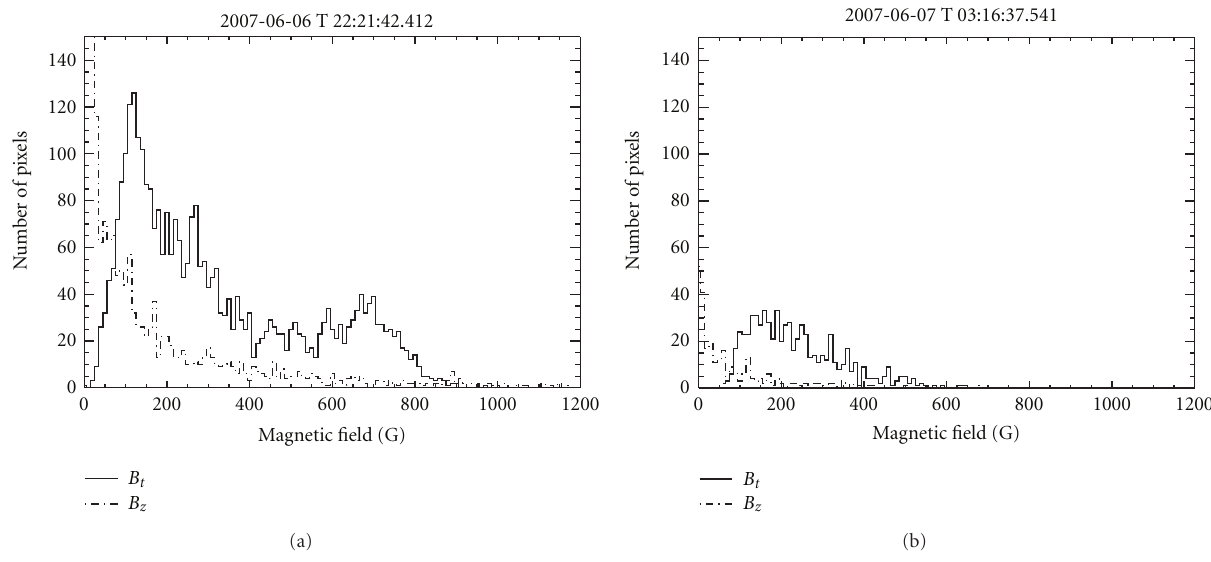
Figure 9: (a) Histogram of the vertical component ( B z ) and transverse component of the magnetic fields ( B t ) are plotted for the PLFs obtained an hour before the flare. (b) Same as the (a) plot, but for the data obtained about two hours after the flare. The thick line corresponds to the histogram of transverse field strength and the dash dotted line corresponds to the histogram of vertical magnetic field